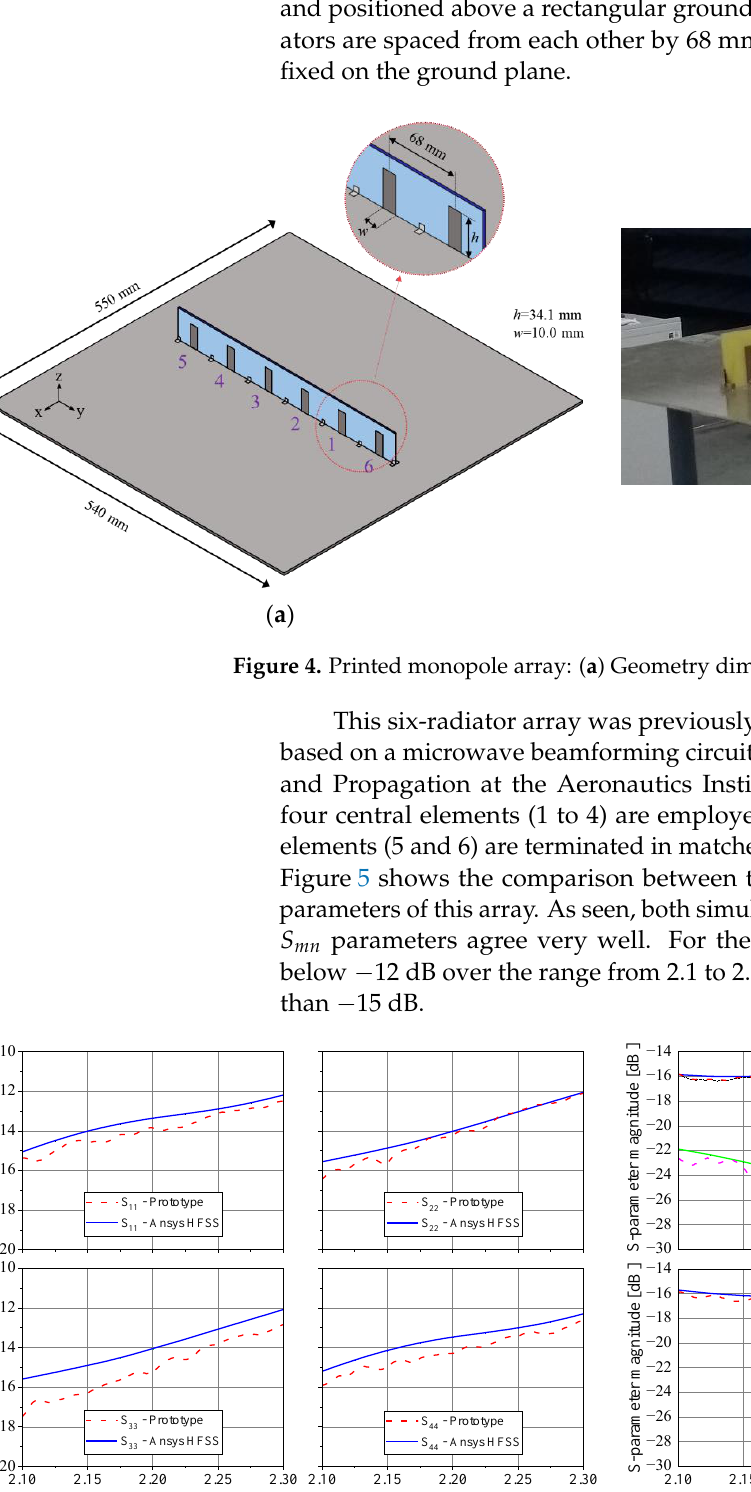
Figure 5. Simulated and measured 𝑆 parameters of the printed monopole antenna array: ( a ) 𝑆 𝑛𝑛 ; ( b ) 𝑆 𝑚𝑛 .